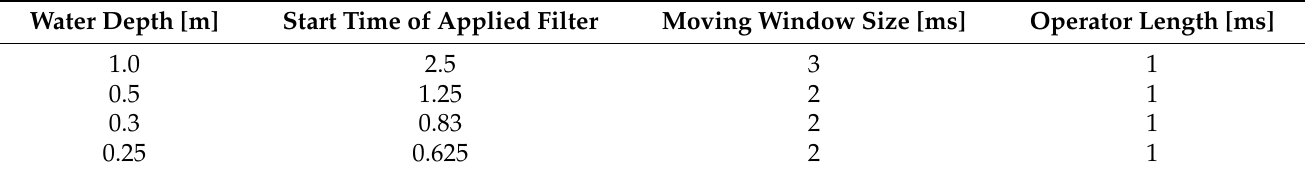
Table 3. Overview of applied parameters for the adaptive subtraction step in VISTA seismic data processing software. Water Depth